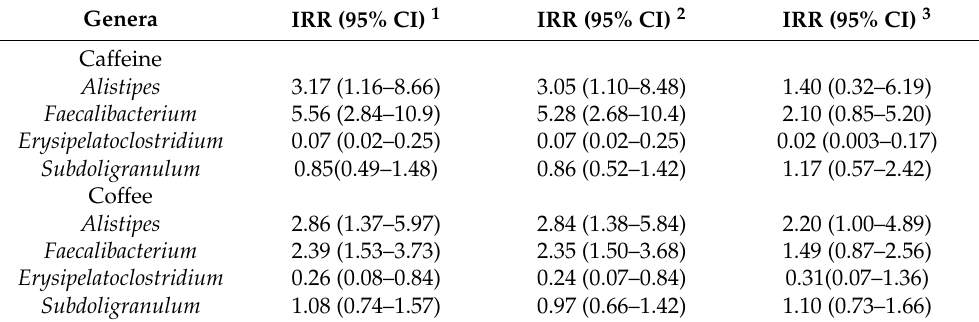
Table 3. Multivariable negative binomial regression analysis of the association between caffeine and coffee intake and a non-zero bacterial